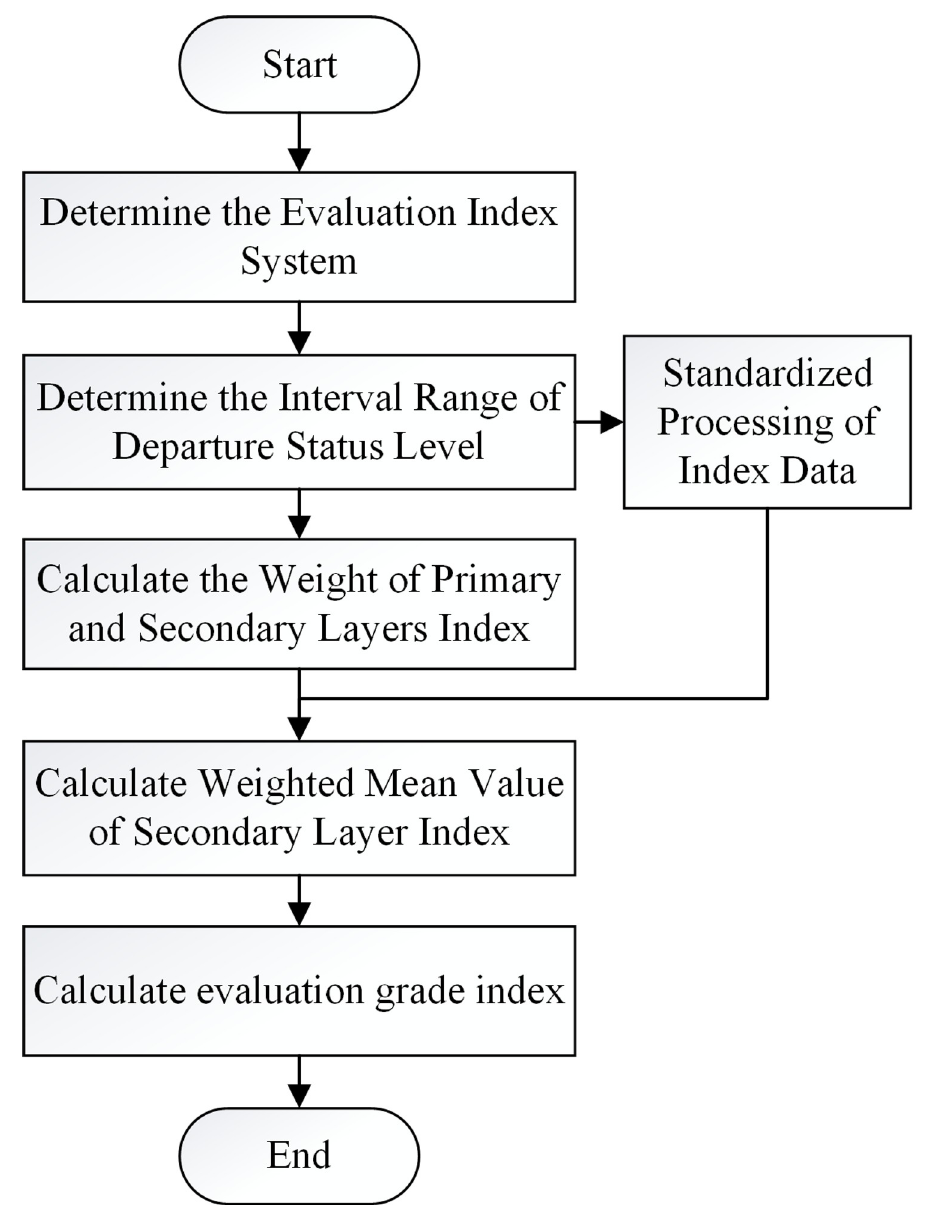
Fig 3. Standardized flow chart for evaluating the efficiency of passenger